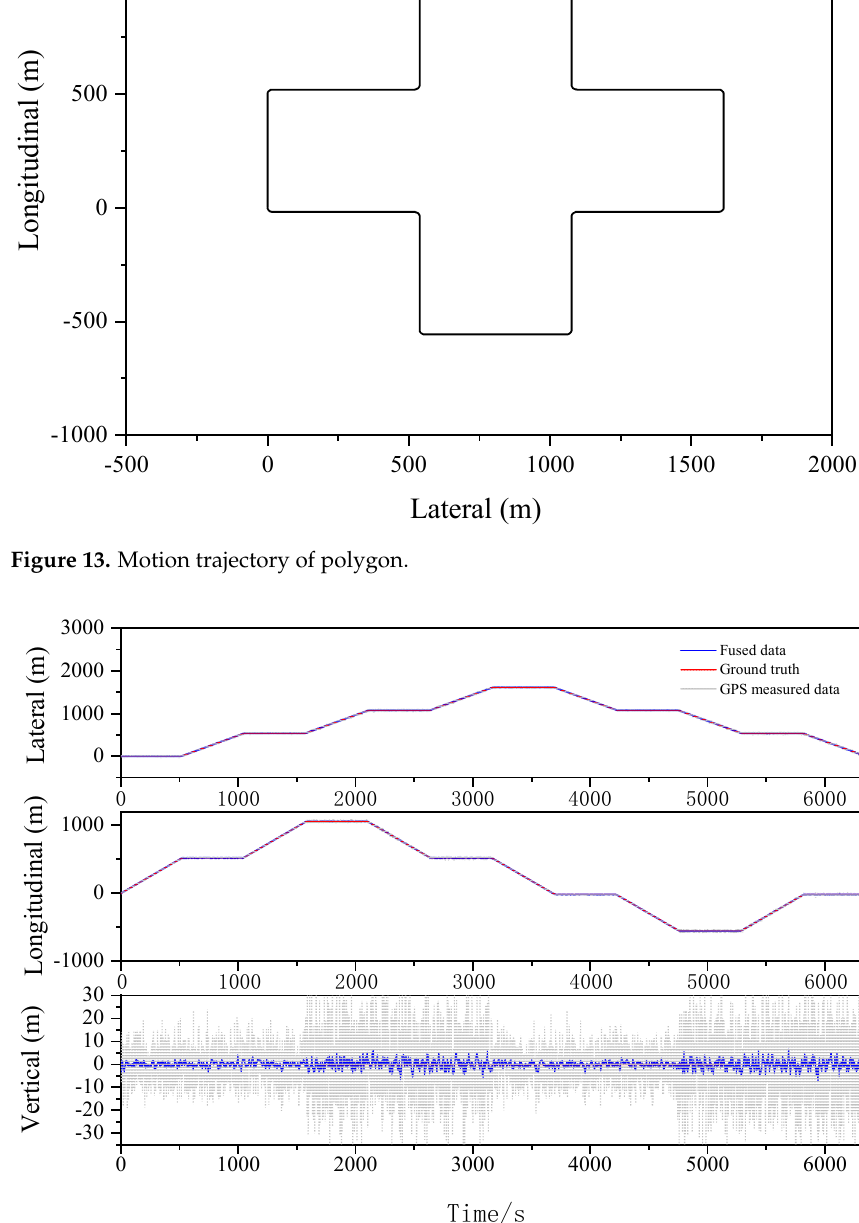
Figure 14. Lateral, Longitudinal and Vertical positions of EKF (Polygonal).